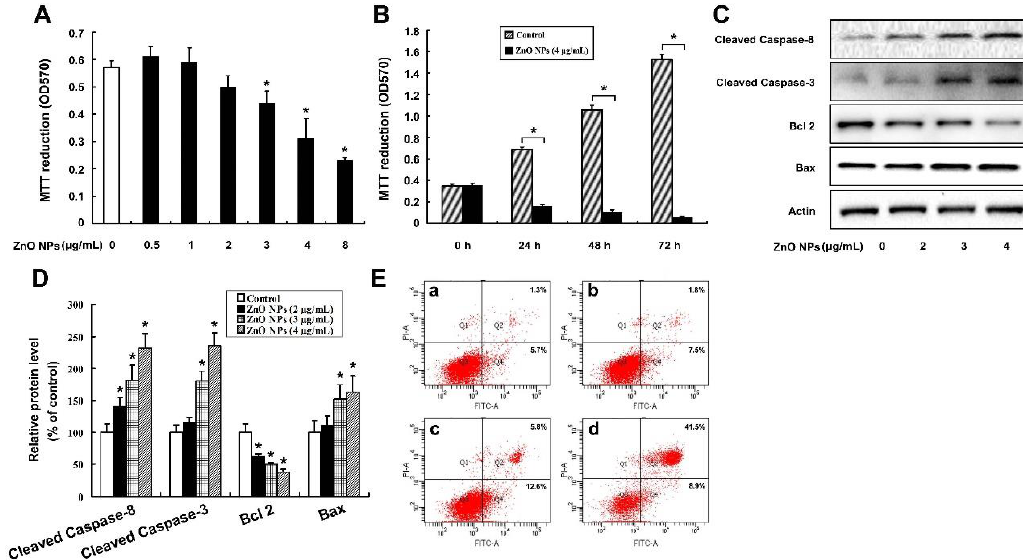
Figure 2. ZnO NPs induce apoptosis in mouse Leydig TM3 cells. 3-(4,5-dimethylthiazol-2-yl)-2,5-diphenyltetrazolium bromide (MTT) assay results of mouse Leydig TM3 cells treated with 0–8 µ g / mL ZnO NPs for 24 h ( A ) or treated with 4 µ g / mL ZnO NPs for 24~72 h ( B ). ( C ) The cells were treated with 0–4 µ g / mL ZnO NPs for 24 h; then, the protein levels of cleaved Caspase-3, cleaved Caspase-8, Bcl 2, and Bax were investigated by Western blot; Actin was used as an internal control. ( D ) The relative protein levels were quantified by densitometry. ( E ) The cells were treated with 0 ( a ), 2 ( b ), 3 ( c ), 4 ( d ) µ g / mL ZnO NPs for 24 h, then the AnnexinV-FITC positive staining cells were counted by flow cytometry. The experiment was done in triplicate and repeated three times. Data were analyzed by one-way ANOVA. * p < 0.05.